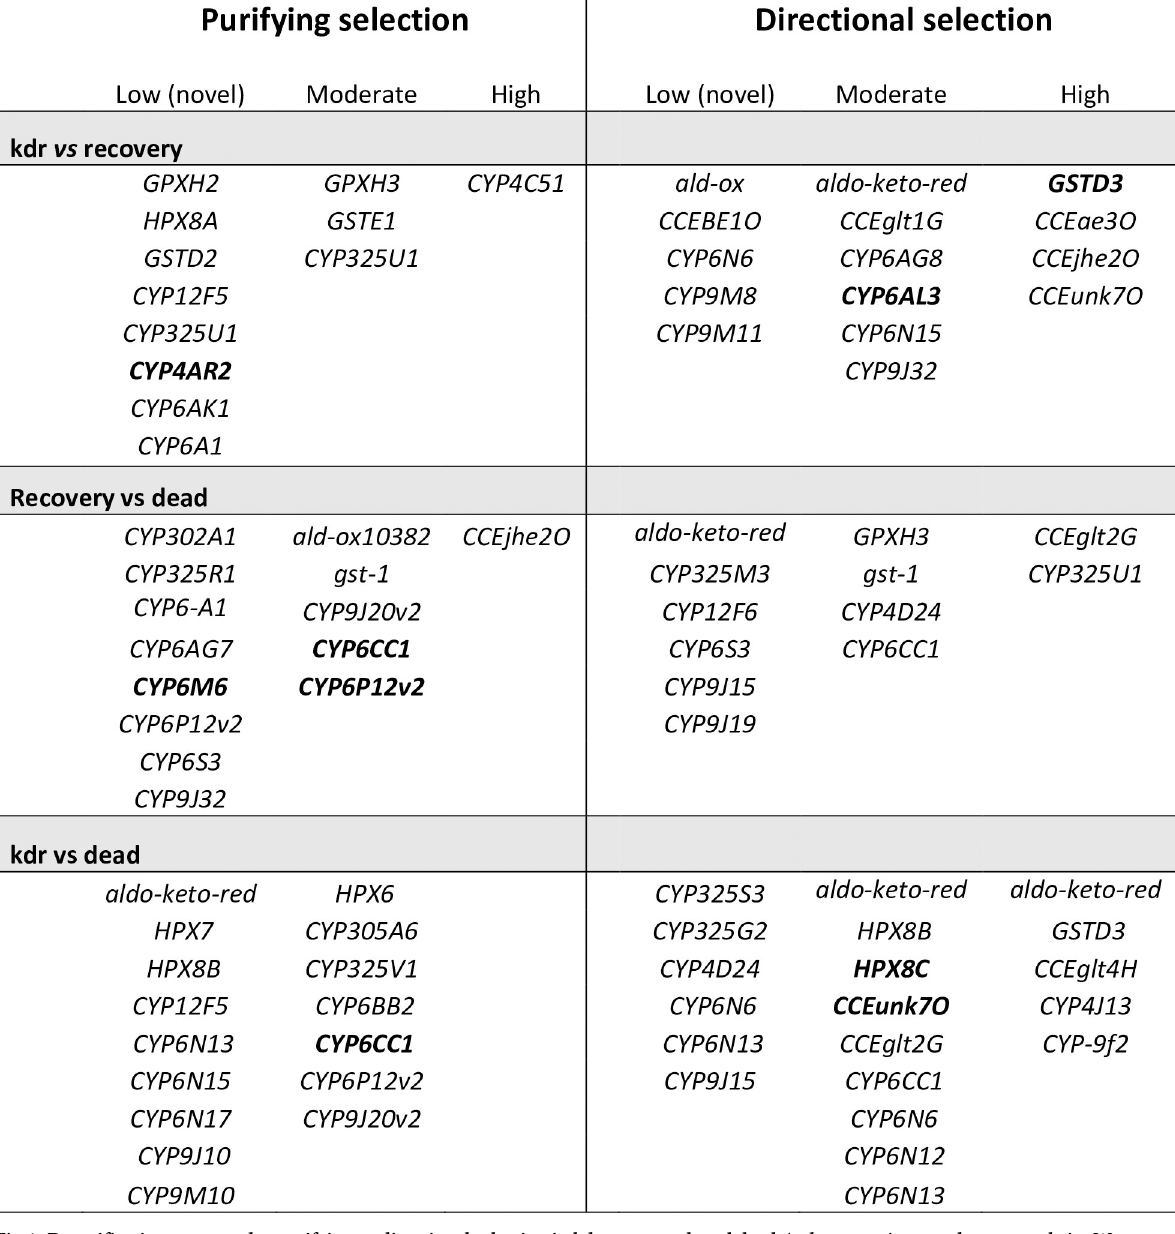
Fig 4. Detoxification genes under purifying or directional selection in kdr, recovered, and dead Aedes aegypti exposed to permethrin. We conducted three pairwise comparisons between phenotypes. The kdr vs recovery comparison involved two different resistant phenotypes. The recovery vs dead and, kdr vs dead comparisons involve one resistant and the susceptible phenotype (dead). If the frequency of the alternant SNP was higher in the resistant phenotype, we labeled the gene as directional selection. If the frequency of the alternant SNP was higher in the susceptible group, we labeled the SNP as purifying. The frequency was categorized as low (probably novel mutations) when the frequency ranged between 0 to 0.4, moderate from 0.4–0.8 and high 0.8 to 1.0. The detoxification genes with the highest LOD values for each comparison are highlighted in